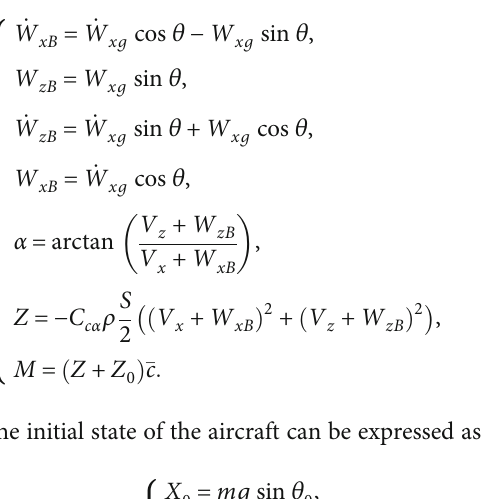
Figure 5: Aircraft longitudinal